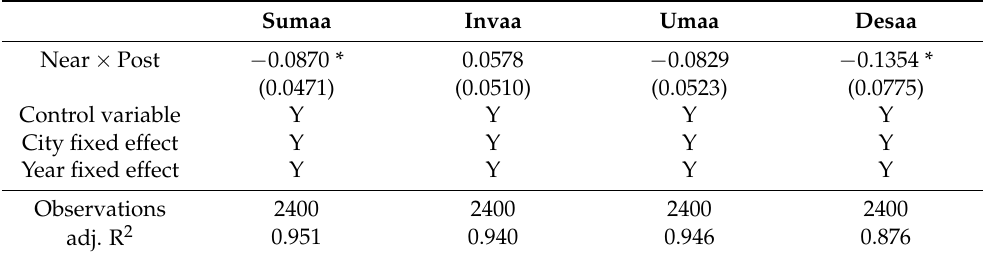
Table 12. Policy effects to neighboring